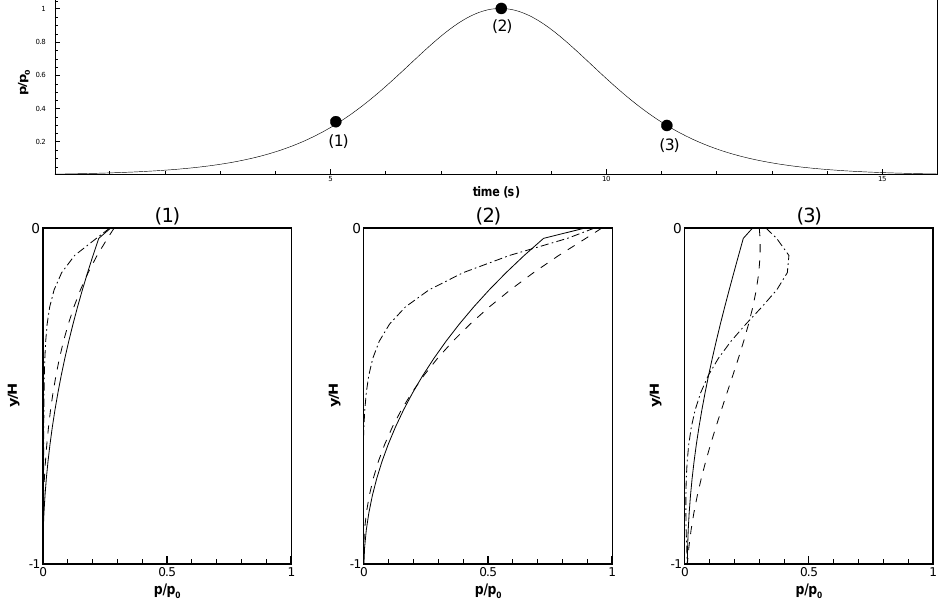
Figure 10. Distribution of excess pore-water pressure for Young’s modulus E = 2.5 × 10 3 kPa, and various permeability coefficients: ——–, k = 2.5 × 10 − 1 m/s; − − − , k = 2.5 × 10 − 2 m/s; − · − , k = 2.5 × 10 − 3